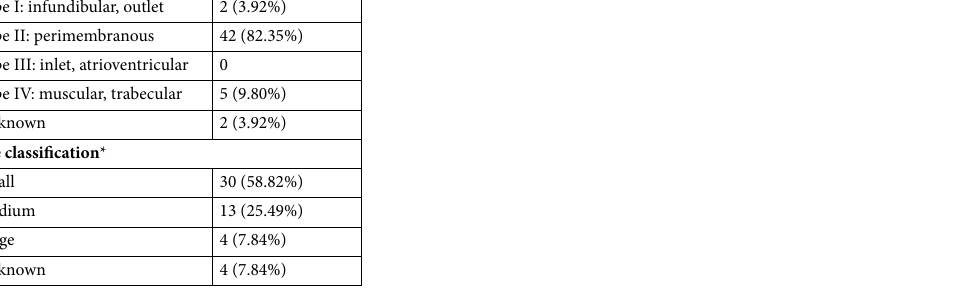
Table 2. Details of the VSD types included in this study. *Small VSD: Qp/Qs < 1.5; medium VSD: 1.5 ≦ Qp/ Qs < 2; large VSD: 2 ≦ Qp/Qs; where Qp indicates pulmonary blood flow, Qs indicates systemic blood flow.